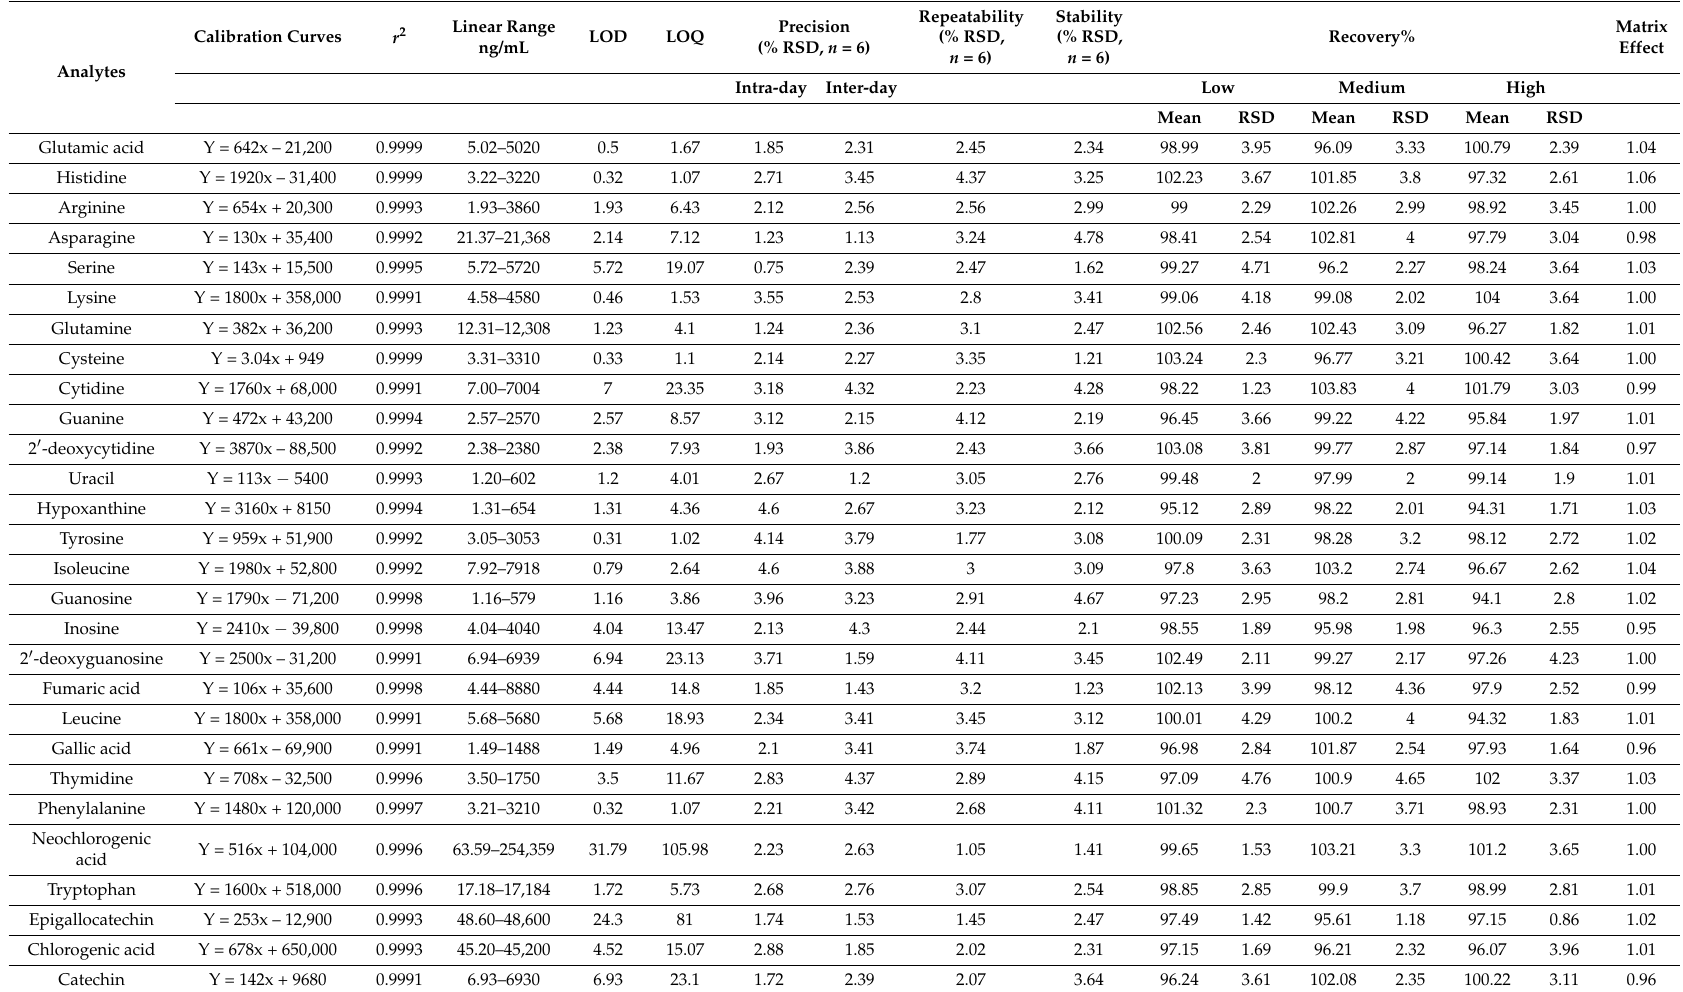
Table 2. Regression equation, correlation coefficient, linear range, limit of detection (LOD), limit of quantitation (LOQ), precision, repeatability, stability, recovery, and matrix effect of 43 investigated